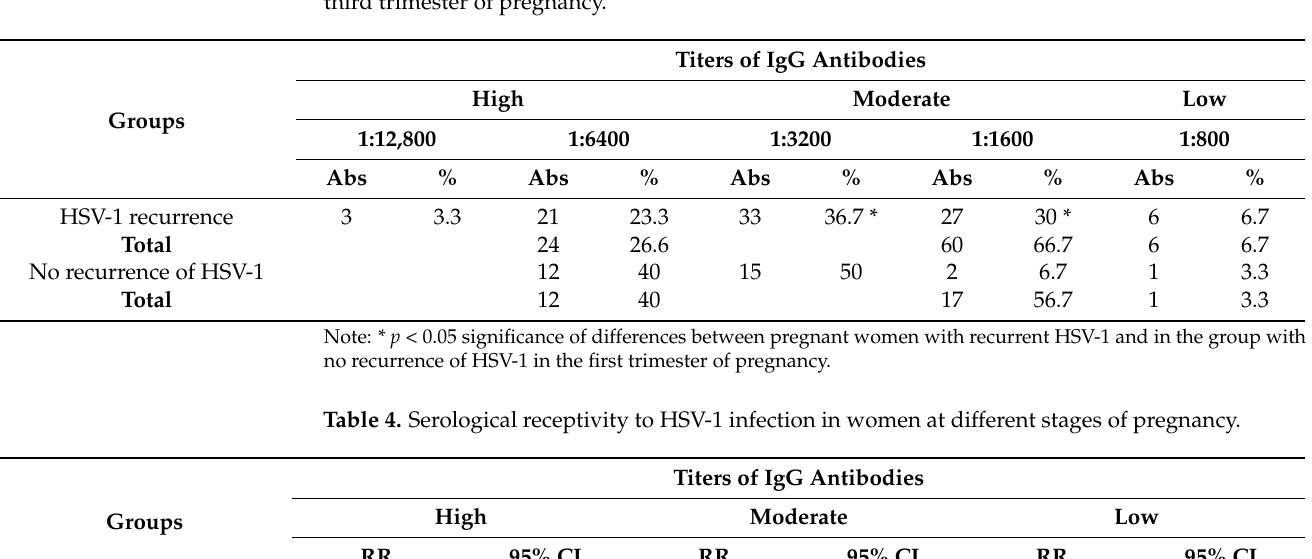
Table 3. Frequency of distribution (%) of IgG antibodies to HSV-1 among pregnant women in the third trimester of pregnancy.